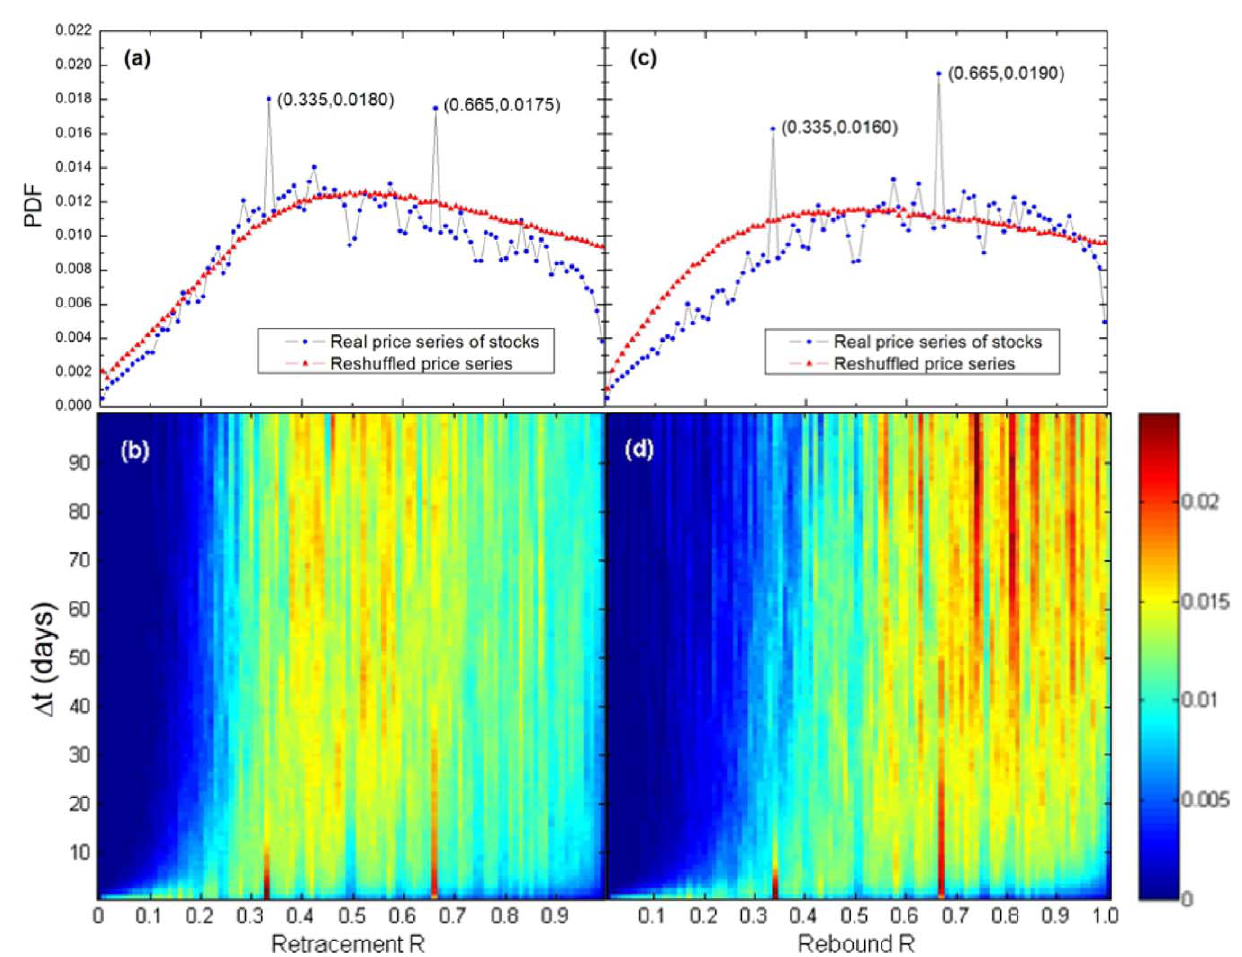
Figure 2. (Color online) PDF of (a,b) renormalized retracements and (c,d) renormalized rebounds of stock prices. (a,c) Overall PDF calculated over D t from 1 day to 100 days and over all trend reversals in the price series of all 500 stocks of the S&P 500 index. Each of them shows a bimodal distribution with two peaks located at two characteristic values of R t (or R b )=0.335 and R t (or R b )=0.665, which are symmetrical with respect to R t (or R b )=0.500. Also shown are the results obtained from randomly reshuffled price series. (b,d) The colored PDF profiles. The color represents the probability density for each given D t . Ridges can be found at R t (or R b )=0.335 and R t (or R b )=0.665. The ridge of R t (or R b )=0.335 stretches from D t ~ 1 day to D t & 10 days. The ridge of R t (or R b )=0.665 stretches from D t ~ 1 day to D t & 30 days.